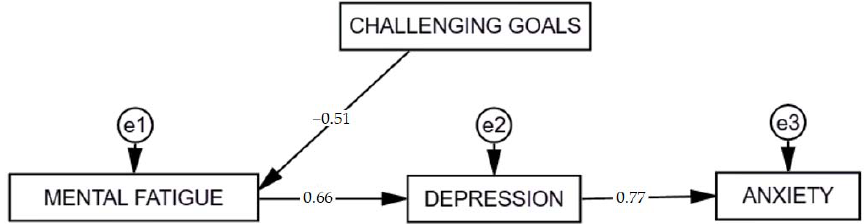
Table 16. Scalar estimates of the model of associations between learning motivating factors, anxiety, depression, and fatigue in the sample of respondents who did not participate in e-learning-based computer programming courses. Figure 3. Path diagram: challenging goals, mental fatigue, depression, and anxiety in participants of e-learning-based computer programming courses.